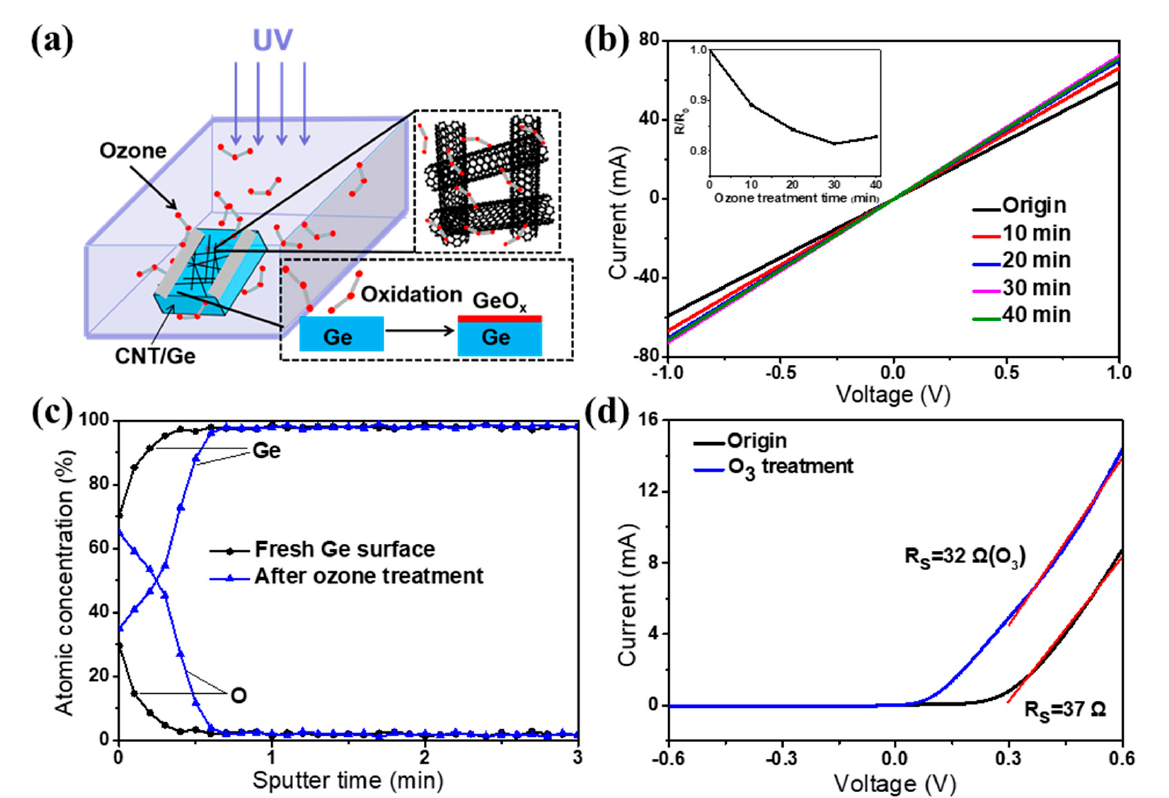
Figure 3. Ozone doping process and characteristics of SWCNT-Ge photodetector. ( a ) A schematic illustration of ozone doping process at the SWCNT films and Ge interface; ( b ) I - V curves of the SWCNT films with different ozone treatment times. Inset shows the relationship between the sheet resistances of SWCNT films and ozone treatment time; ( c ) Depth-resolved Auger electron spectrum of germanium and oxygen atomic concentrations in a fresh Ge substrate and after ozone treatment; ( d ) Dark I - V curves of the SWCNT-Ge photodetector before and after ozone treatment.